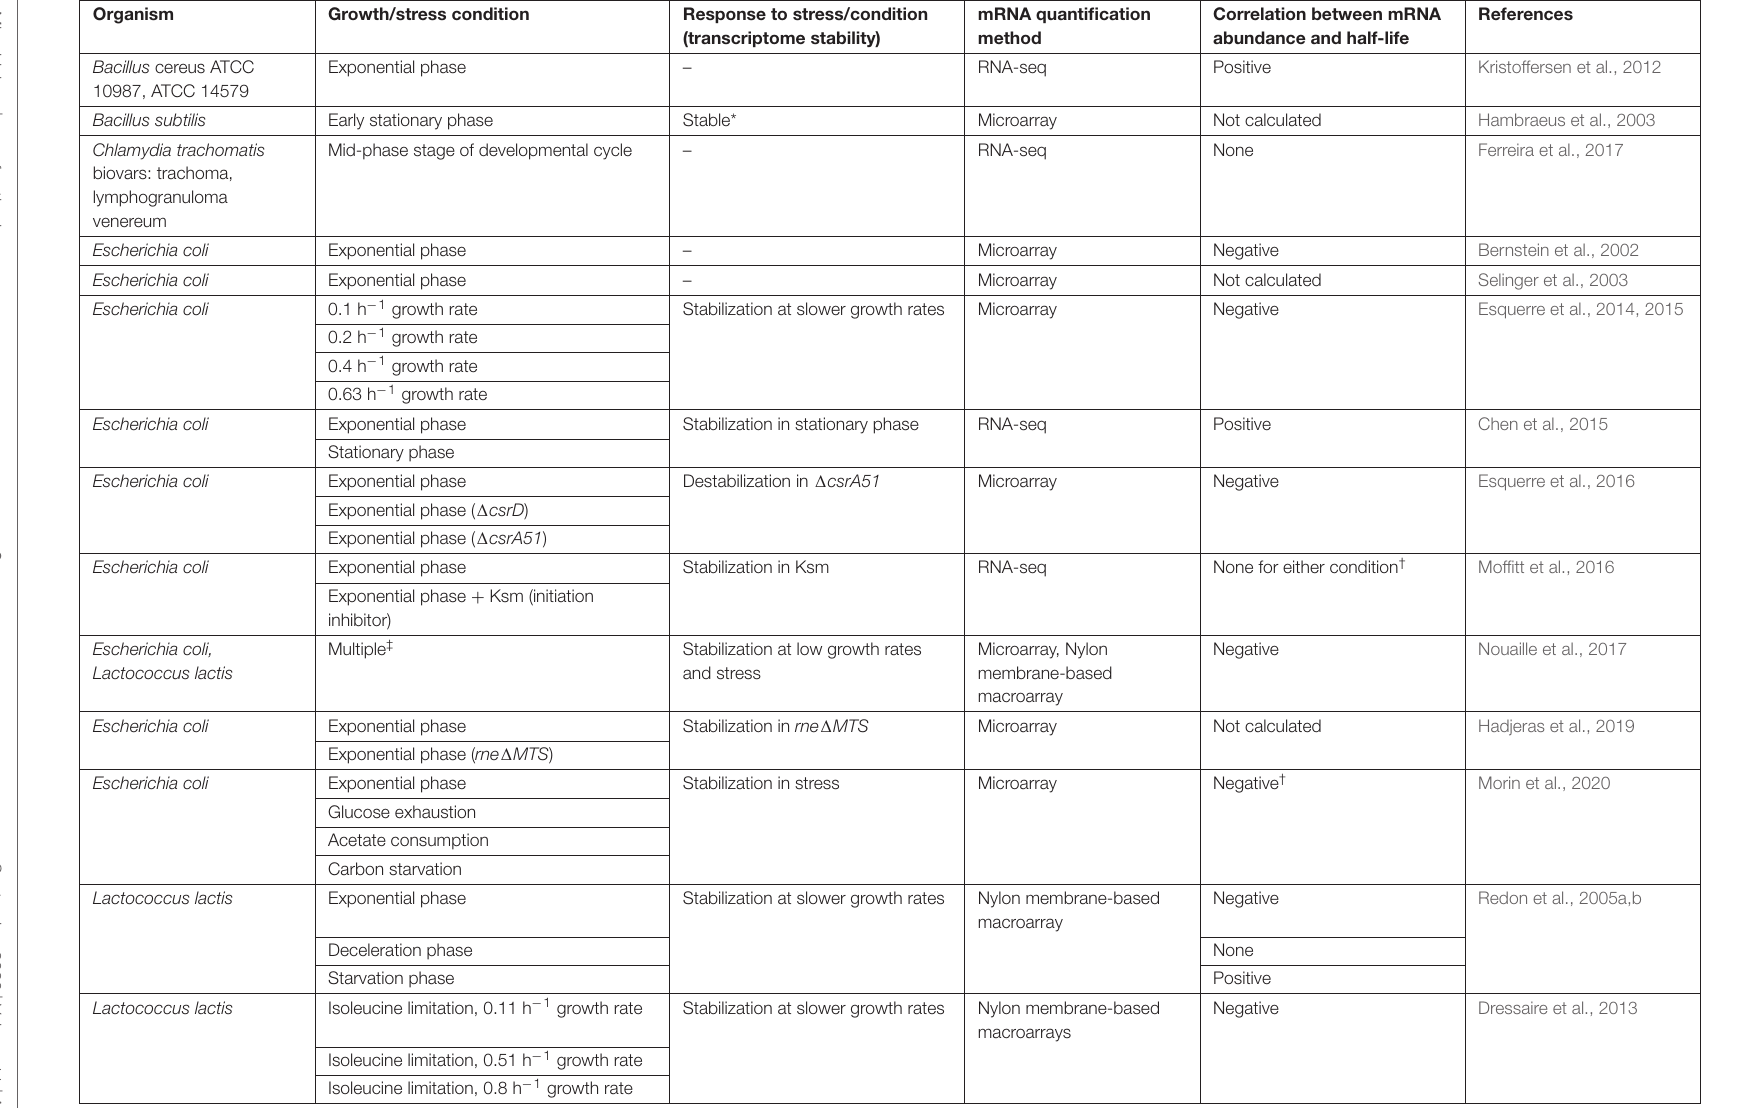
TABLE 1 | Transcriptome-wide studies on mRNA half-life in bacteria.